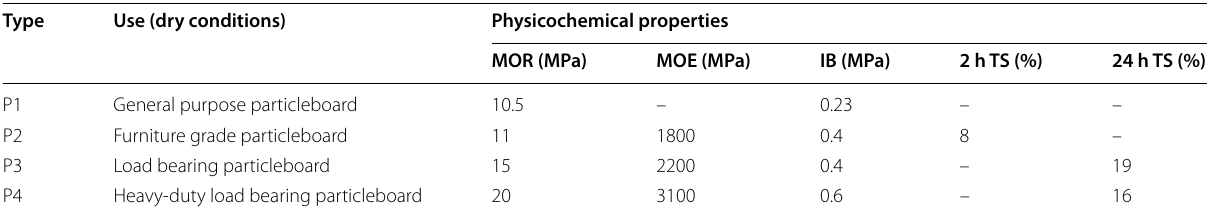
Table 3 Standard for physicochemical properties of particleboard of China [17] (6 mm < thickness < 13 mm)